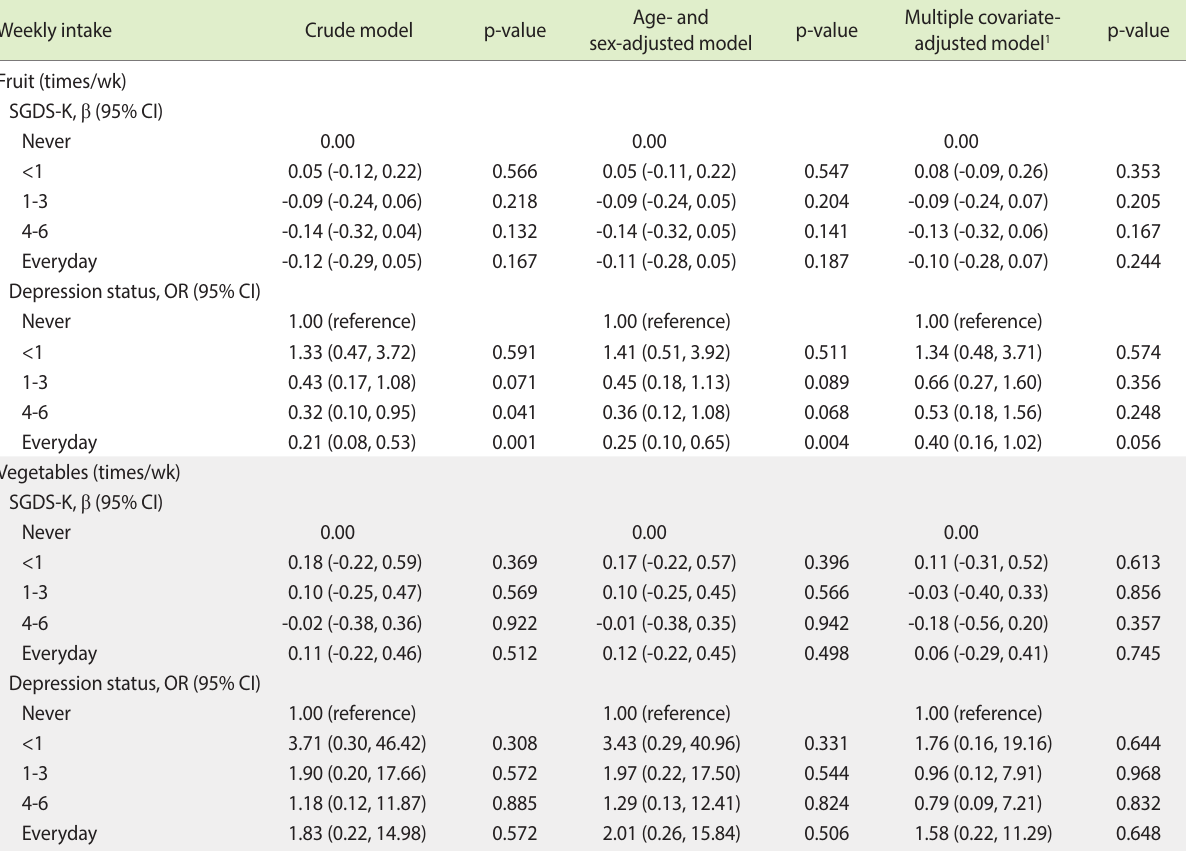
Table 3. Generalized linear mixed-effects models for the association of weekly fruit/vegetable intake with SGDS-K and depression